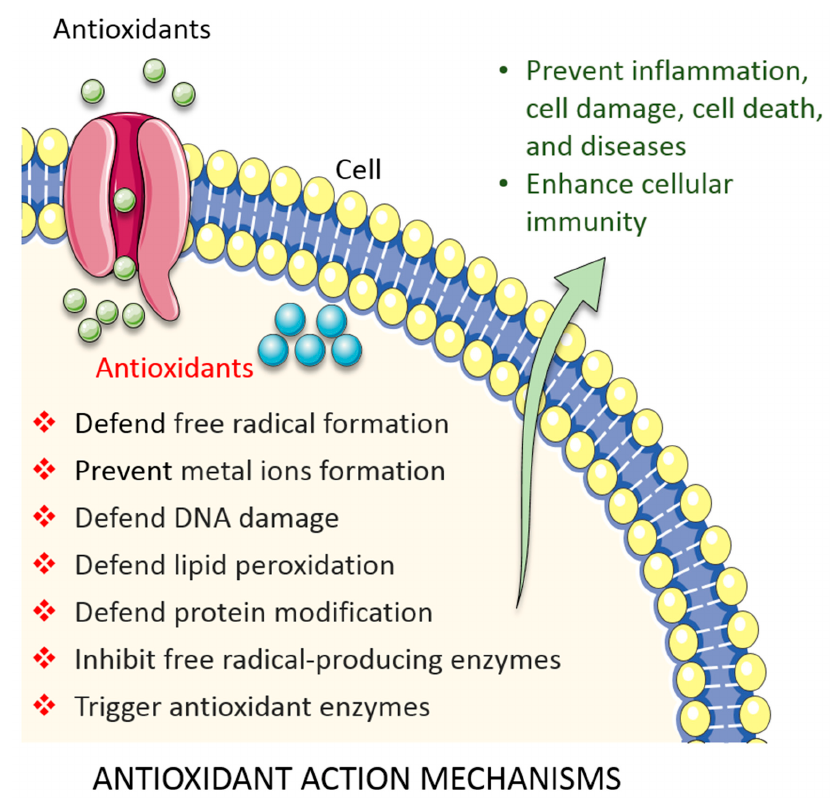
Figure 2. Overview of antioxidant defence systems in cell. See the main text for details.